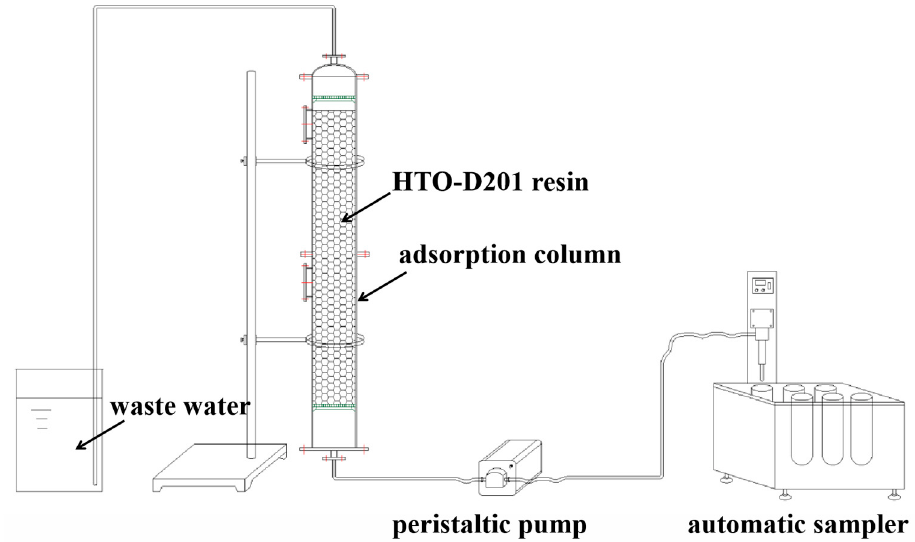
Figure 2. Schematic diagram of the column adsorption experiment.